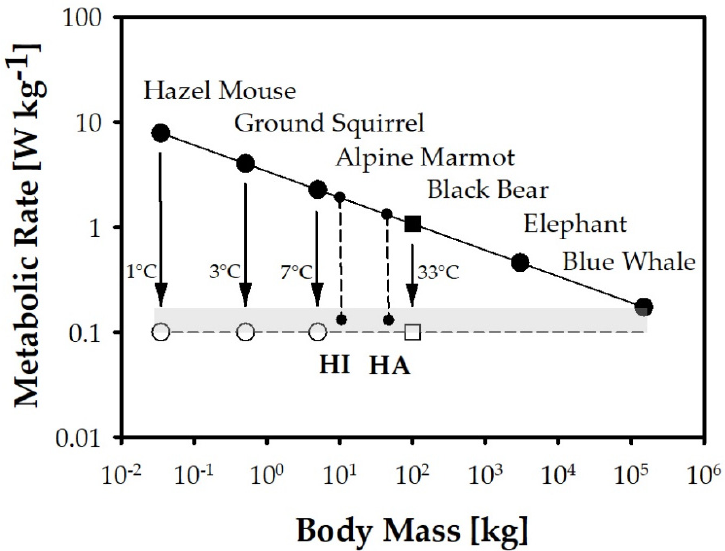
Figure 1. Tolerance to metabolic reduction as a function of body size. Following a general biological rule (“mouse-to elephant curve”), the specific (i.e., weight-related) basal metabolic rate of mammals (in watts per kg) decreases with increasing body mass [10–12]. Hibernating species (e.g., hazel mouse, ground squirrel, alpine marmot), while overwintering at near-zero body temperatures, reduce their metabolic rate to a fairly uniform minimal level that equals the specific basal metabolic rate achieved by the very largest mammals (elephant, blue whale) by body size alone [13–15]. Black bears fit into this overall hibernation pattern even though their body temperature remains higher (approximately 33 ◦ C) and the relative amount of metabolic reduction is smaller due to their lower size-related basal metabolic rate [16,17]. Although there is no strict correlation between the (endogenous) metabolic reduction and the (concomitant) temperature decline in hibernators (both in hazel mice and in black bears, the magnitude of metabolic reduction exceeds the pure temperature effect), this relationship suggests an increasing hypothermia tolerance with decreasing body mass among mammals. This may also explain why human infants (HI) and small children tend to tolerate a higher degree of cold-induced metabolic reduction than human adults (HA), owing to their larger metabolic “drop height” [5,6].